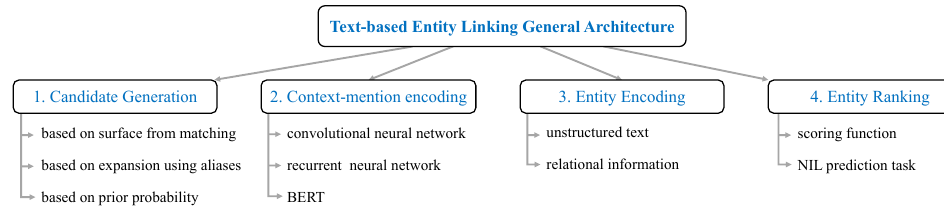
Figure 7. Reference graph of text-based entity linking general